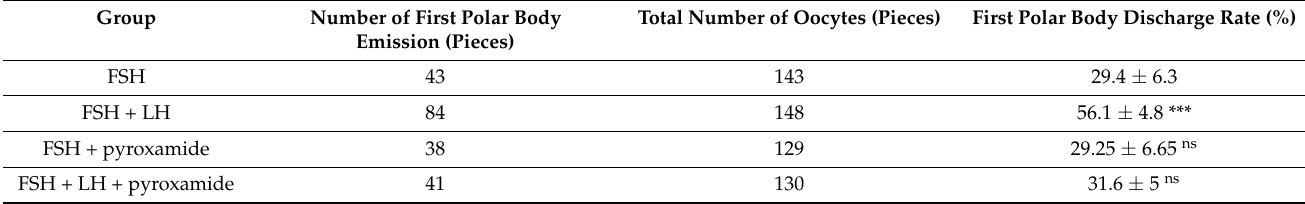
Table 2 . Effect of HDAC1 inhibitor on oocyte maturation ( n = 4). Table 2. Effect of HDAC1 inhibitor on oocyte maturation ( n = 4).